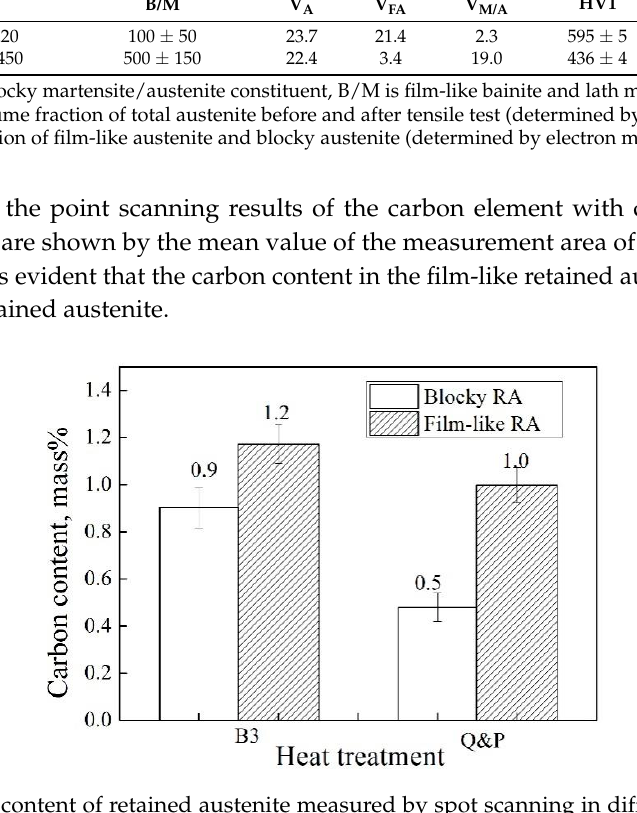
Figure 4. Carbon content of retained austenite measured by spot scanning in different heat treated samples before dynamic tensile testing.